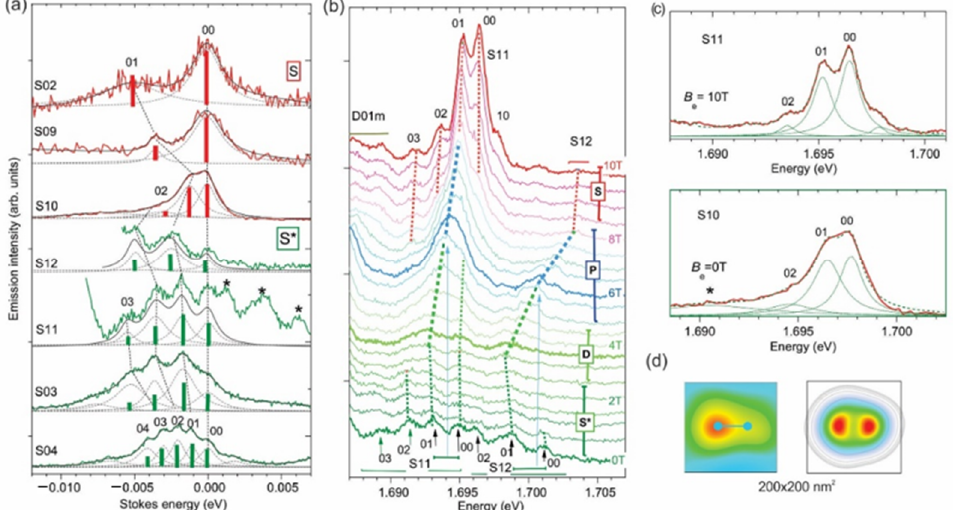
Figure 1. ( a ) Comparison of PL spectra (thick lines) S and S* 1e InP/GaInP 2 QDs (see Table 1) at B e = 0 T. Thin/dashed lines are Lorentzian contour decomposition of the spectra and bars are calculated 0 N transition intensities (red and green for B = 0 and ~7 T, respectively, see text). The star symbols denote the neighboring dots. ( b ) PL spectra of S11and S12 InP/GaInP 2 QDs measured at B e = 0, 0.5, 1.0, . . . and 10 T. Dashed lines connect the positions of the peak maxima. ( c ) Comparison of PL spectra of S11 ( upper ) and S10 ( lower ). QDs measured at B e = 10 and 0 T, respectively. Dashed lines are the spectrum and its constituents obtained from Lorentzian contour decomposition. The star symbols denote the neighboring dot. ( d ) Measured NSOM PL intensity distribution ( left ) and calculated 2e-WM electron density ( right ) for the S10 QD. The dumbbell in the left image corresponds to d WM , as-measured from the experimental PL